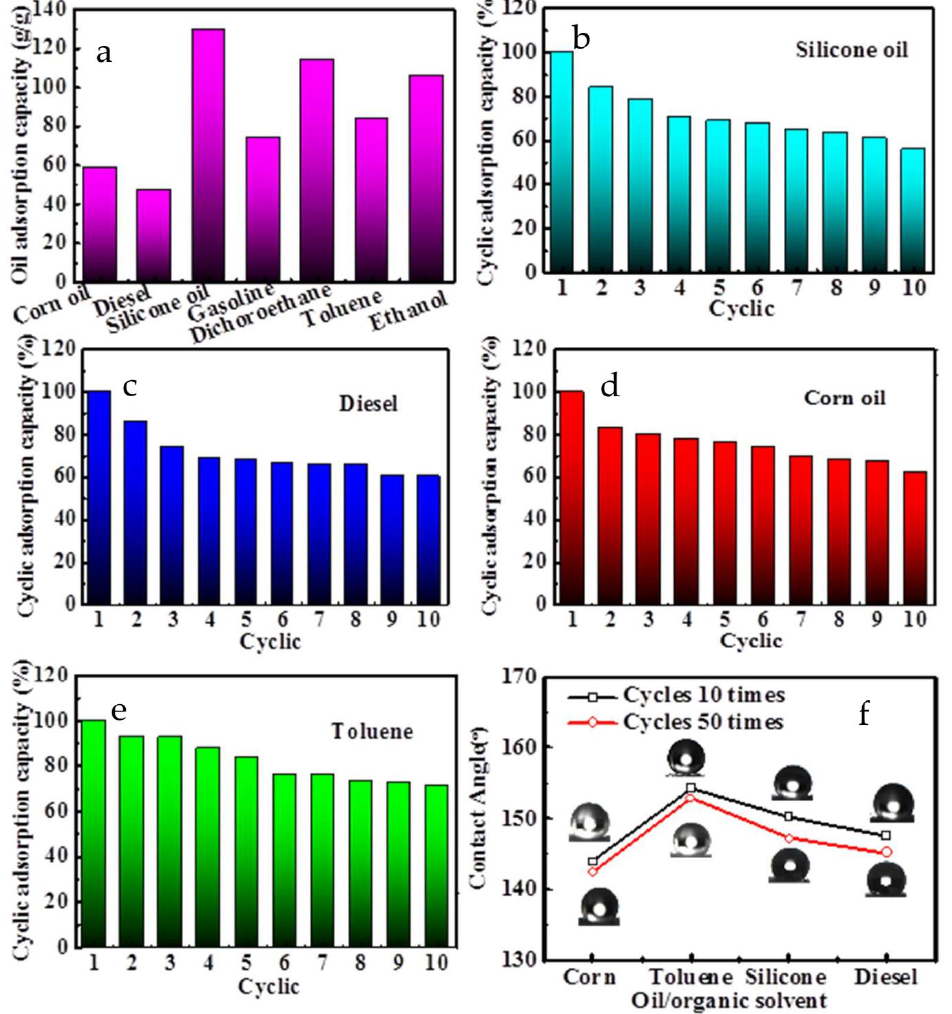
Figure 6. The oil adsorption capacity of the MS–TA–Ag ( a ) and the cyclic serviceability ( b – e ) of the MS–TA–Ag for various types of oils/organic solvent. ( f ) The water contact angle of the MS–TA-Ag after absorbing and extruding different oil/organic solvent for 10 and 50 cycles.